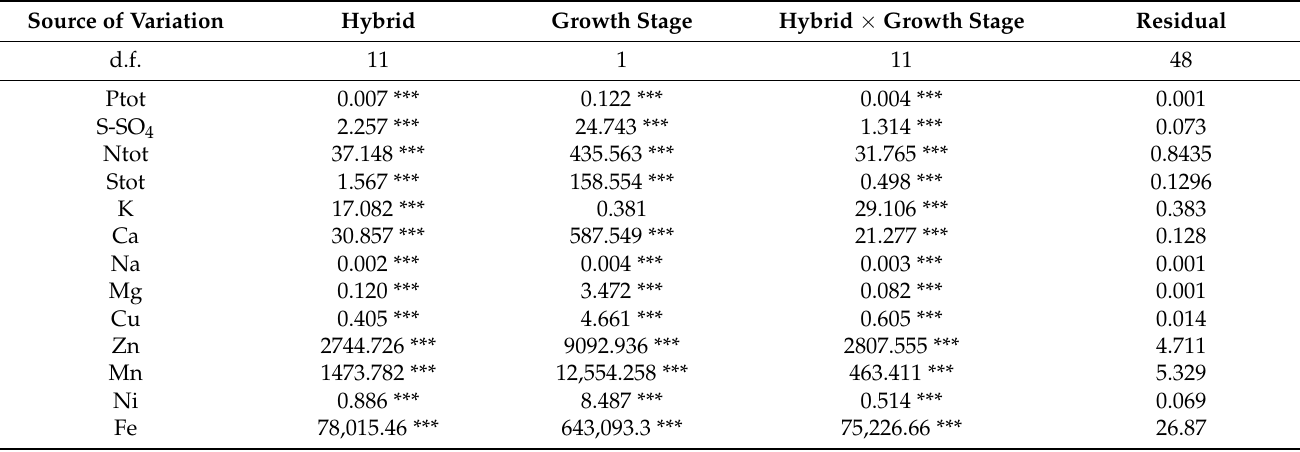
Table 2. Mean squares form two-way analysis of variance for analyzed